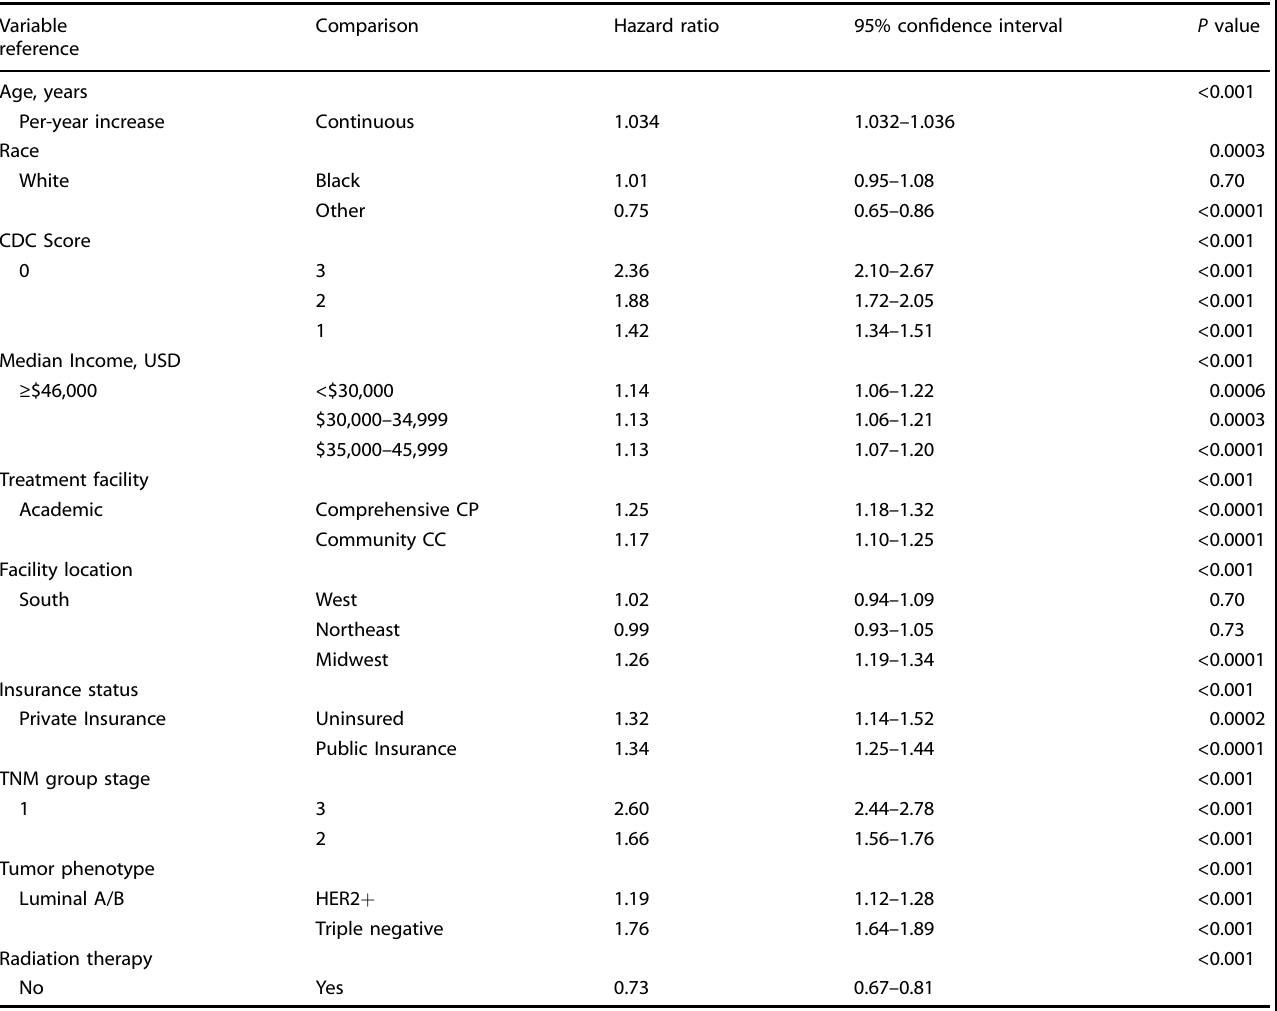
Table 2. Multivariate analysis of factors associated with overall